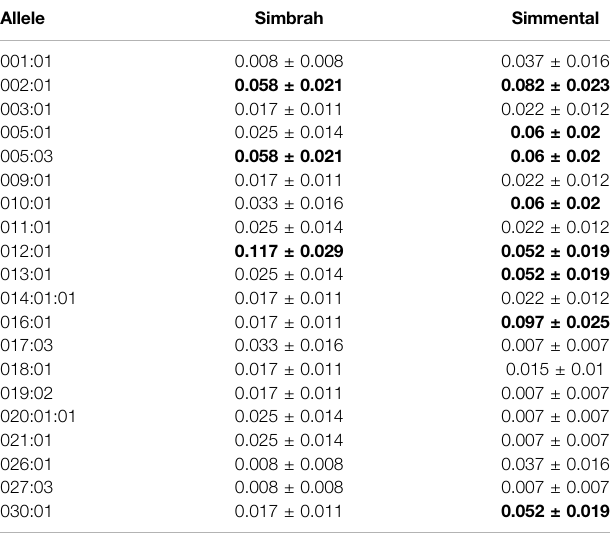
TABLE 2 | Allele frequency and standard error for BoLA-DRB3 alleles common to Simmental and Simbrah cattle.